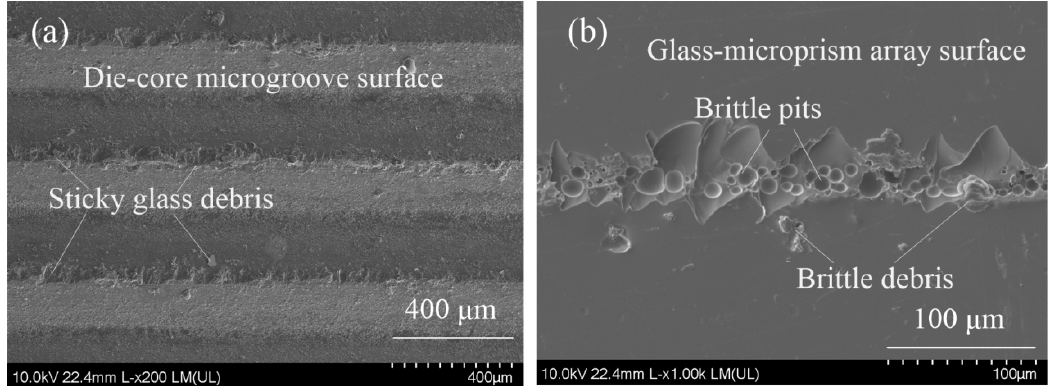
Figure 10. Forming defects during hot-embossing glass-microprism array process: ( a ) glass debris sticking on surface of die-core microgrooves; ( b ) brittle pits and debris on glass-microprism array surface (embossing temperature 700 °C, holding duration 10 min, embossing force 0.755 N).